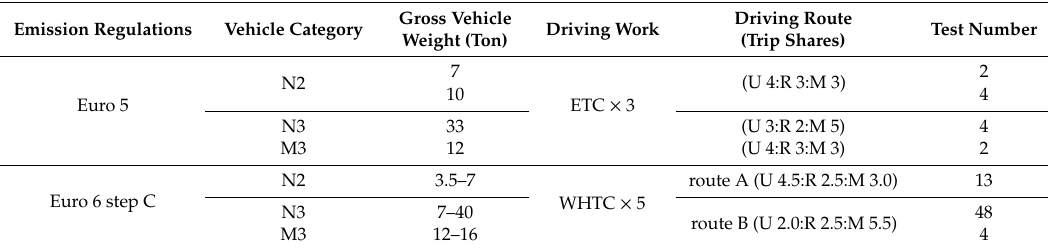
Table 1. Specifications of tested heavy-duty diesel